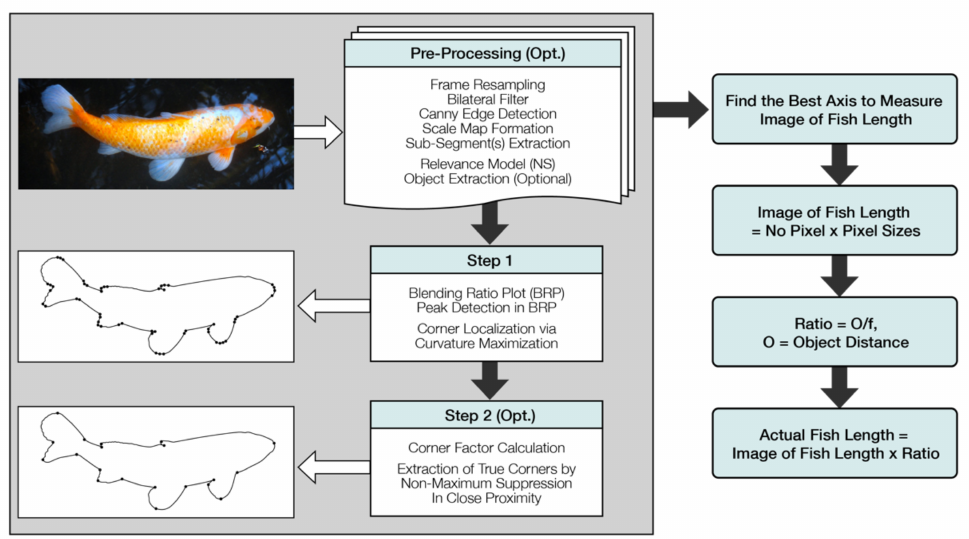
Figure 12. Flow chart of FLUDI